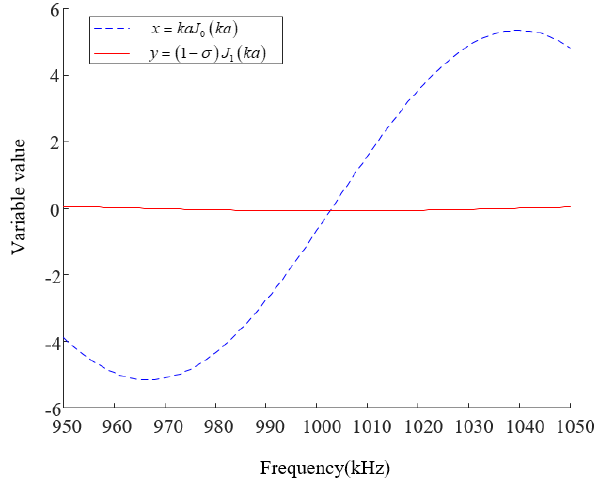
= 12.3 × 10 − 12 m 2 /N, 11